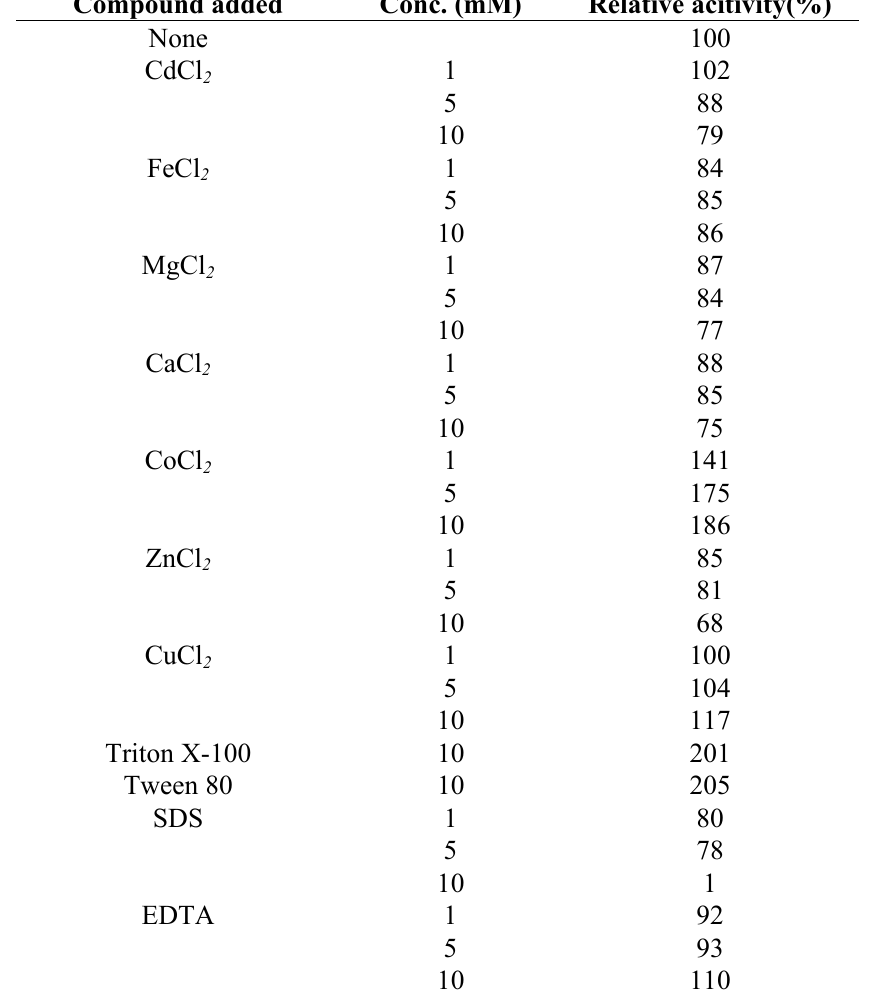
Table 2. Effects of metal ions, surfactants and EDTA on the purified recombinant EGLB